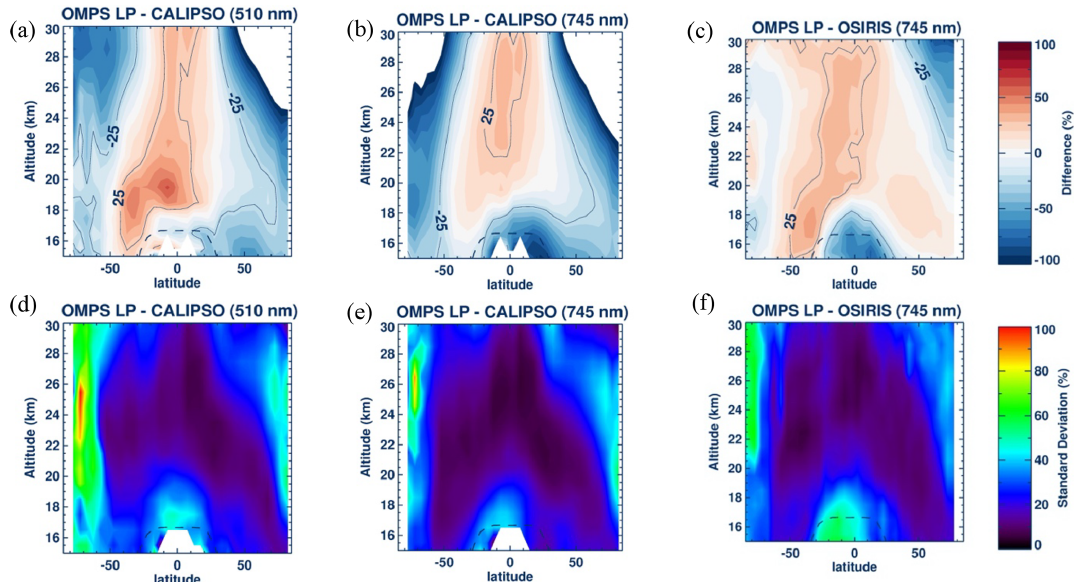
Figure 15. Panels (a) – (c) show the mean difference between OMPS LP and (a) CALIPSO 532, (b) CALIPSO 745, and (c) OSIRIS 745nm measurements in percent. The dashed line is the tropopause altitude, and the contour line is for differences greater than ± 25%. Panels (d) – (f) are the same as the top panels but for the 1 − σ standard deviation or spread of difference between OMPS LP and CALIPSO 510 (d) , CALIPSO 745 (e) , and OSIRIS 745nm (f)